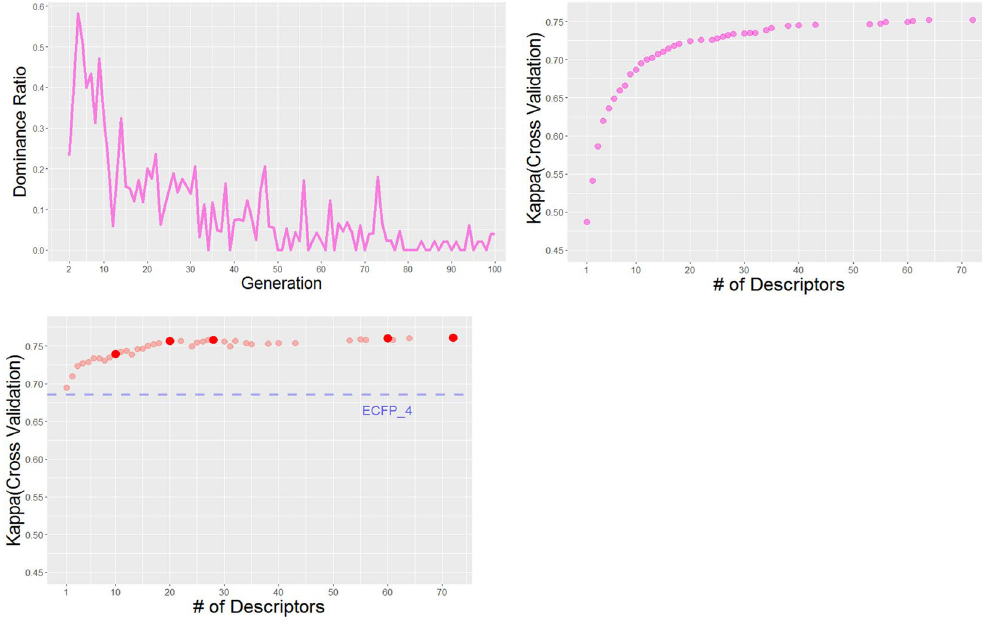
Figure 1. The result of descriptor selection by NSGA-II. ( a ) Ratio of dominated Pareto solutions of previous generation at generation t . ( b ) The Kappa statistics and the number of used descriptors of the descriptor sets in the 100th generation. ( c ) Results of the combination of the Pareto solutions descriptor set and ECFP_4. The selected descriptor sets for model building are highlighted. The kappa statistics of the SVM model only using ECFP_4 is shown as dashed